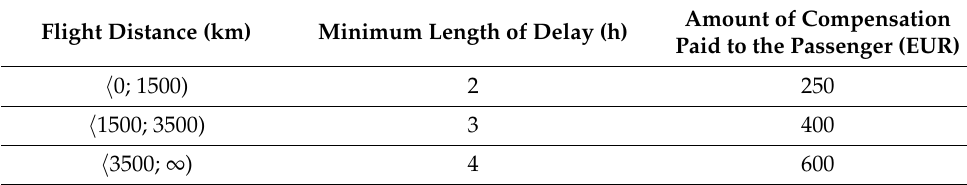
Table 1. Amount of financial compensation for passengers